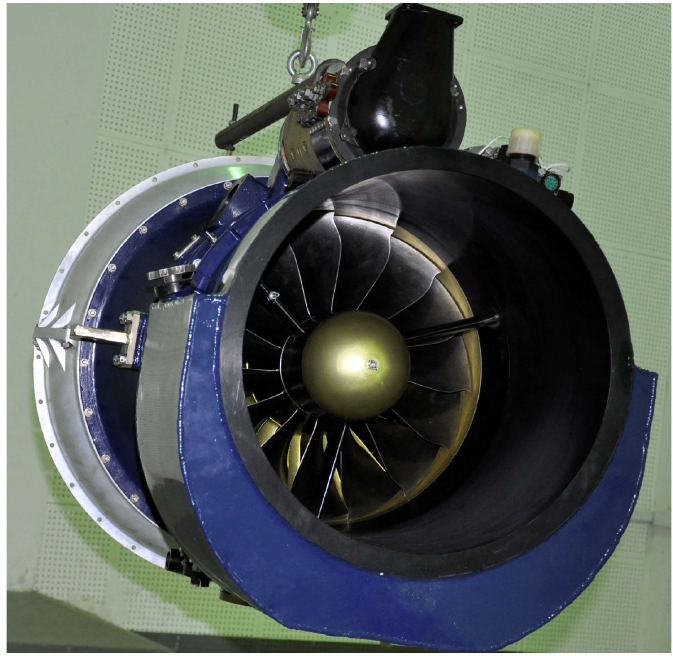
Figure 2. Physical map of the